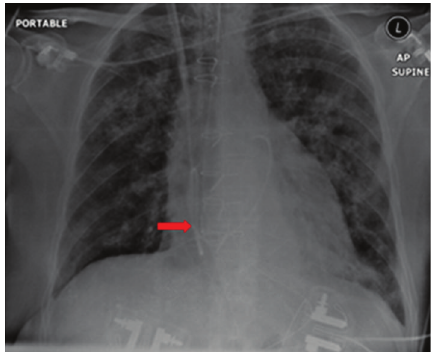
Figure 4: A CXR showing a Swan Ganz catheter forming a loop in the IVC